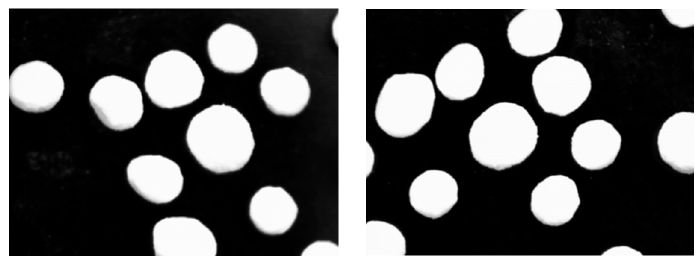
Figure 1. Visual assessment of different batches of the inert pellets (30× magnification).